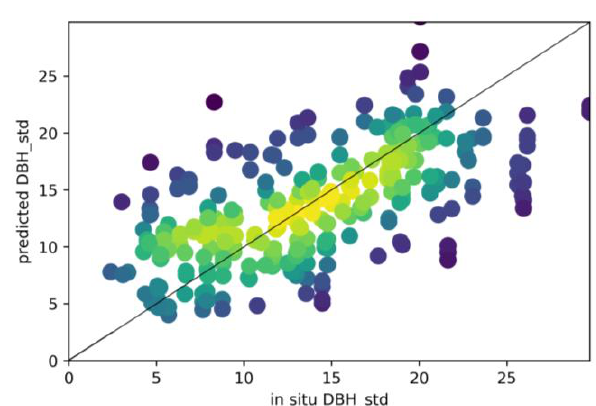
Figure 8: Scatter plot of predicted vs. in situ standard deviation of diameter at breast height (DBH_std) in